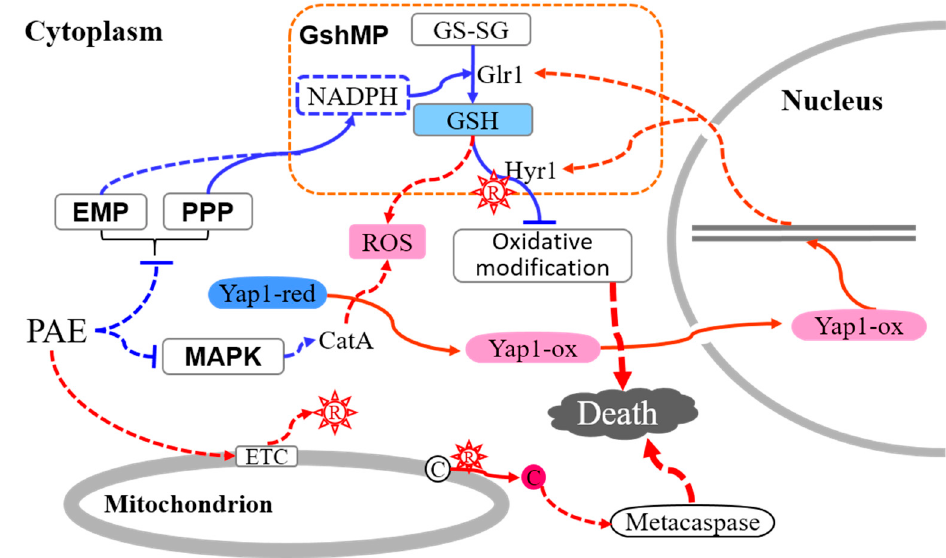
Figure 9. A schematic illustration of the potential mechanism that PAE induces cell death in A. flavus .